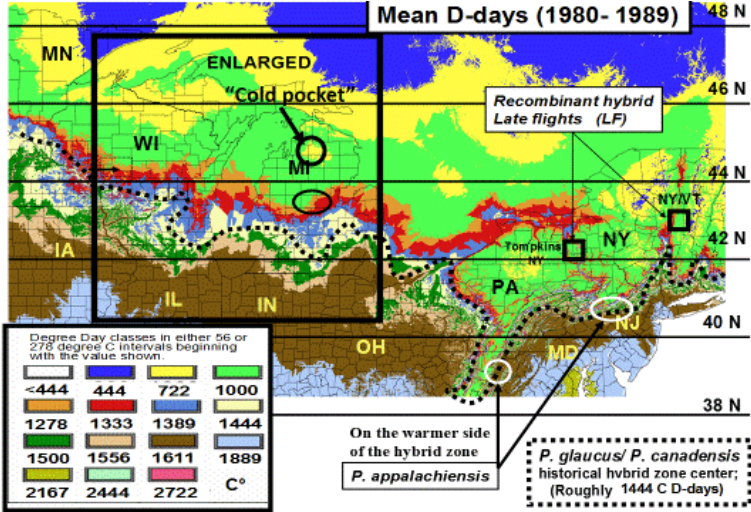
Figure 3. The thermal landscape of eastern North America showing the center of the historical hybrid zone (dotted line) between Papilio glaucus and P . canadensis as a function of the mean annual Degree-day accumulations above a base of 50 °F (=10 °C) for the decade from 1980 (cid:177) 1989 (1960 (cid:177) 1979 was very similar). The center of this zone (and northern limits of bivoltine potential in P . glaucus ) is at approximately 2600 D-days F (or 1444 C D-days). The P . appalachiensis populations are shown on the warm side of the hybrid zone (in the mountains of Pennsylvania and West Virginia), while the recombinant (cid:179)(cid:79)(cid:68)(cid:87)(cid:72) - (cid:73)(cid:79)(cid:76)(cid:74)(cid:75)(cid:87)(cid:180)(cid:3) (cid:75)(cid:92)(cid:69)(cid:85)(cid:76)(cid:71)(cid:3) (cid:83)(cid:82)(cid:83)(cid:88)(cid:79)(cid:68)(cid:87)(cid:76)(cid:82)(cid:81)(cid:86)(cid:3) (cid:75)(cid:68)(cid:89)(cid:72)(cid:3) (cid:69)(cid:72)(cid:72)(cid:81)(cid:3) (cid:71)(cid:72)(cid:86)(cid:70)(cid:85)(cid:76)(cid:69)(cid:72)(cid:71)(cid:3) (cid:73)(cid:85)(cid:82)(cid:80)(cid:3) (cid:70)(cid:72)(cid:81)(cid:87)(cid:85)(cid:68)(cid:79)(cid:3) (cid:68)(cid:81)(cid:71)(cid:3) (cid:72)(cid:68)(cid:86)(cid:87)(cid:72)(cid:85)(cid:81)(cid:3) (cid:49)(cid:72)(cid:90)(cid:3) (cid:60)(cid:82)(cid:85)(cid:78)(cid:3) State, on the cool side of this thermally- (cid:71)(cid:72)(cid:73)(cid:76)(cid:81)(cid:72)(cid:71)(cid:3)(cid:75)(cid:92)(cid:69)(cid:85)(cid:76)(cid:71)(cid:3)(cid:93)(cid:82)(cid:81)(cid:72)(cid:17)(cid:3)(cid:55)(cid:75)(cid:72)(cid:3)(cid:50)(cid:87)(cid:86)(cid:72)(cid:74)(cid:82)(cid:3)(cid:70)(cid:82)(cid:88)(cid:81)(cid:87)(cid:92)(cid:3)(cid:179)(cid:70)(cid:79)(cid:76)(cid:80)(cid:68)(cid:87)(cid:76)(cid:70)(cid:3) (cid:70)(cid:82)(cid:79)(cid:71)(cid:3)(cid:83)(cid:82)(cid:70)(cid:78)(cid:72)(cid:87)(cid:180)(cid:3)(cid:76)(cid:81)(cid:3)(cid:81)(cid:82)(cid:85)(cid:87)(cid:75)(cid:72)(cid:85)(cid:81)(cid:3)(cid:48)(cid:76)(cid:70)(cid:75)(cid:76)(cid:74)(cid:68)(cid:81)(cid:3)(cid:76)(cid:86)(cid:3)(cid:76)(cid:81)(cid:71)(cid:76)(cid:70)(cid:68)(cid:87)(cid:72)(cid:71)(cid:3)(cid:75)(cid:72)(cid:85)(cid:72)(cid:15)(cid:3)(cid:68)(cid:81)(cid:71)(cid:3)(cid:68)(cid:79)(cid:86)(cid:82)(cid:3)(cid:76)(cid:81)(cid:3)(cid:87)(cid:75)(cid:72)(cid:3) enlargement (Figure